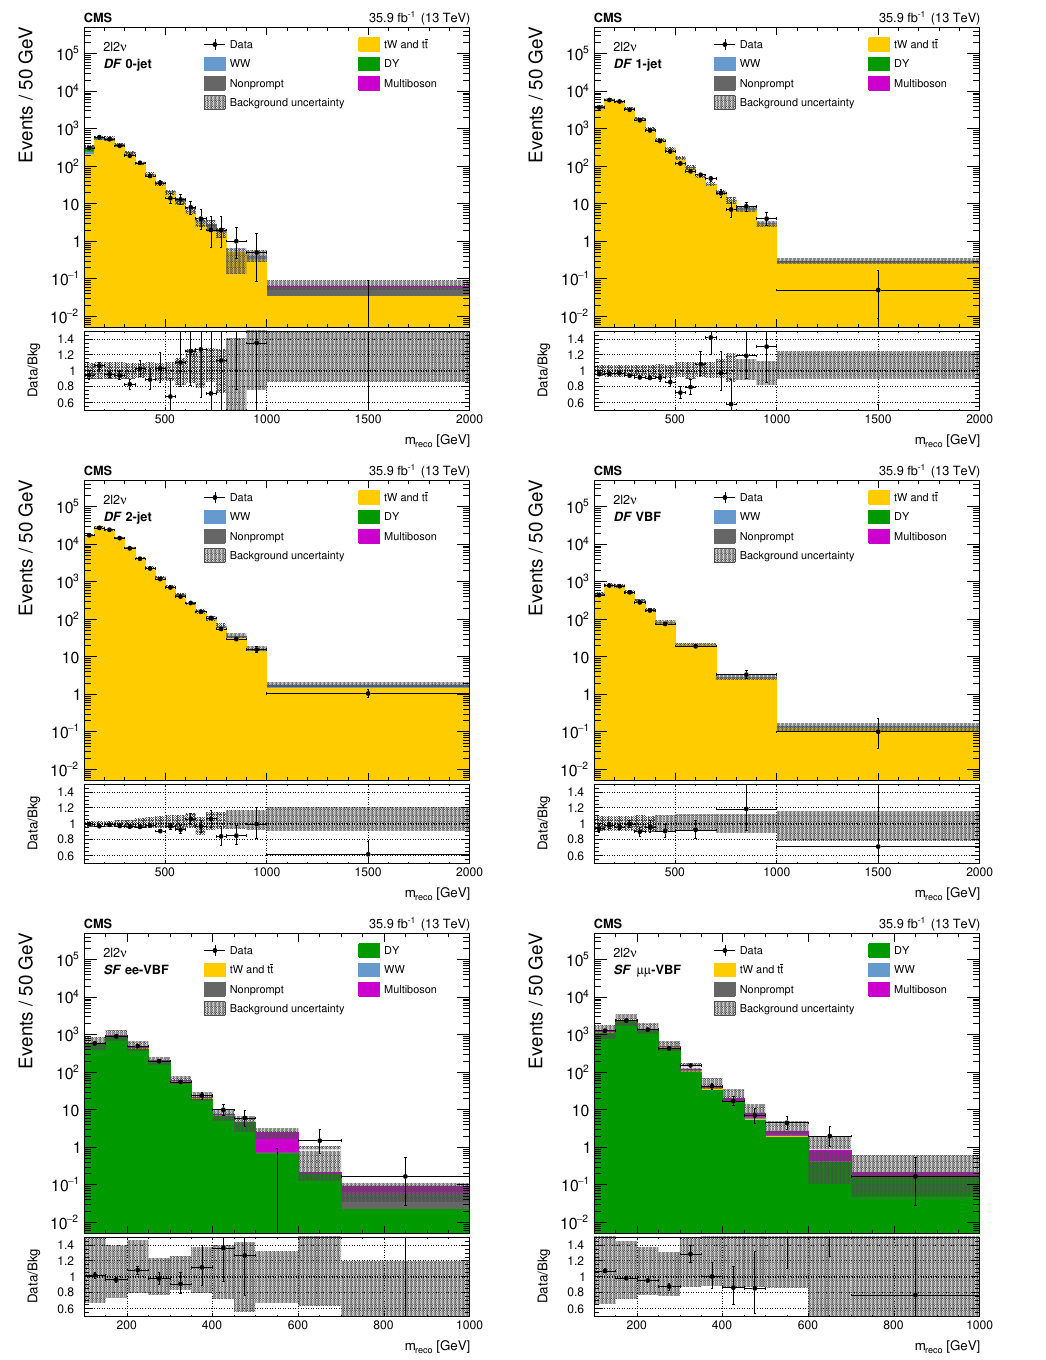
Figure 4 . The m distributions in the top quark control regions of the 2 ‘ 2 (cid:23) di(cid:11)erent-(cid:13)avour reco categories (upper and middle) and the DY control regions of the 2 ‘ 2 (cid:23) same-(cid:13)avour categories (lower). The points represent the data and the stacked histograms show the expected backgrounds. The hatched area shows the combined statistical and systematic uncertainties in the background estimation. Lower panels show the ratio of data to expected background. Larger bin widths are used at higher m ; the bin widths are indicated by the horizontal error reco